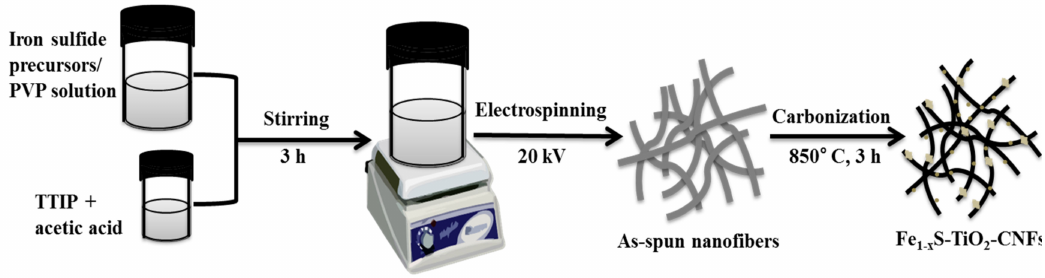
Figure 1. Schematic diagram showing the preparation of Fe 1 − x S-TiO 2 nanoparticles embedded carbon nanofibers (Fe 1 − x S-TiO 2 / CNFs)